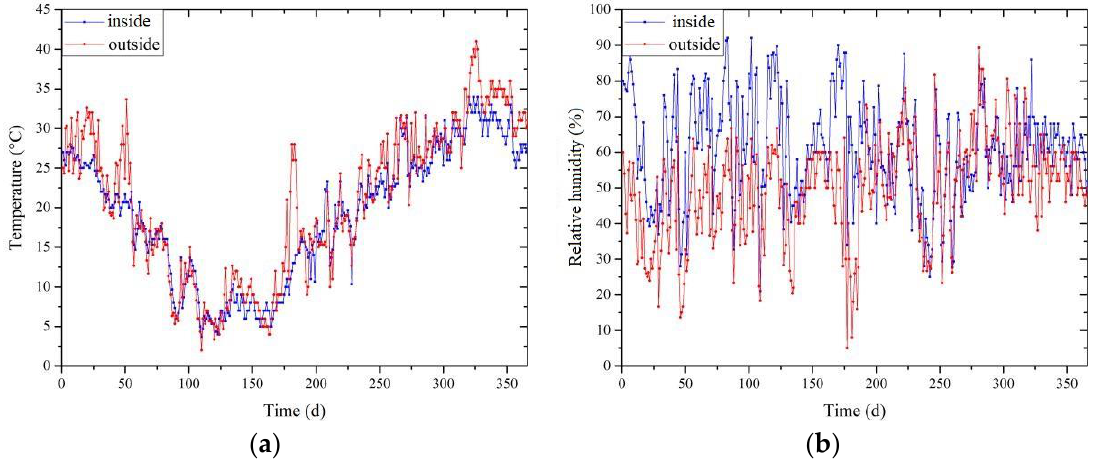
Figure 8. Temperature and humidity curves during the test period: ( a ) Indoor and outdoor temperatures vs. time curves; ( b ) indoor and outdoor humidity vs. time curves.